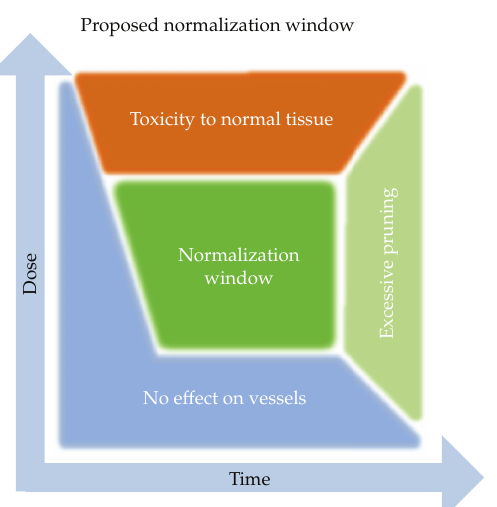
Figure 1: Proposed e ff ect of drug dose and schedule on tumor vasculature normalization window (cid:5) 2 (cid:6)